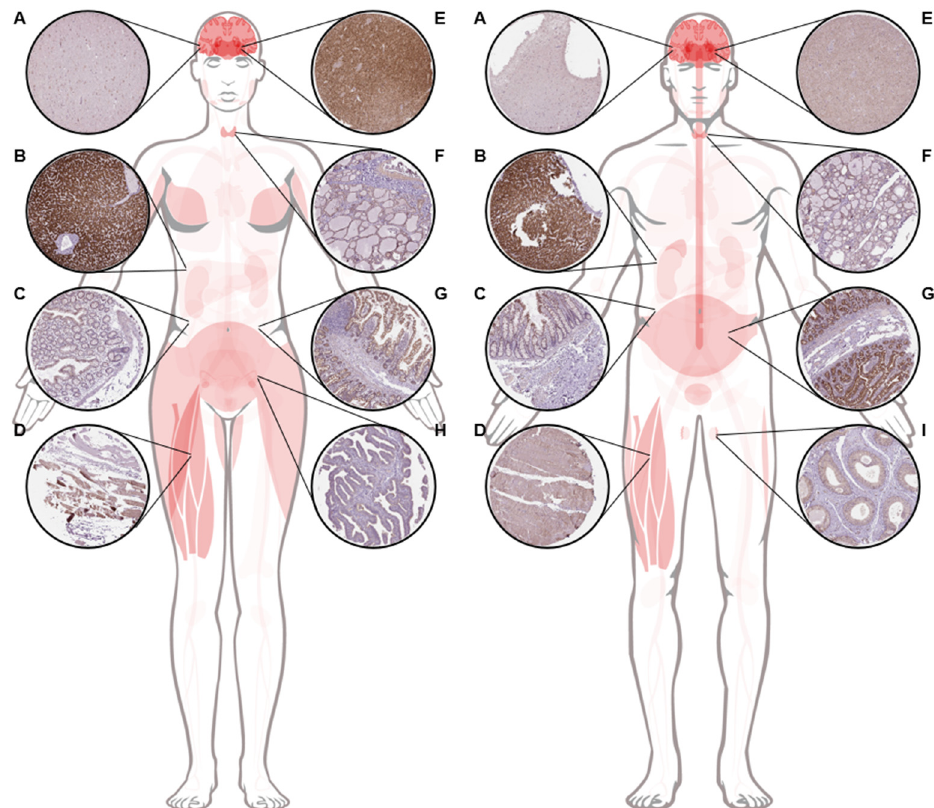
Figure 3. Anatomogram of LRP1B expression in normal human tissue. LRP1B expression data was derived from the antibody-based profiling of 76 different cell types corresponding to 44 normal human tissue types. Figure was prepared using anatomograms and immunohistochemistry images from version 20.1 of Human Protein Atlas available from https://www.proteinatlas.org/ENSG00000168702-LRP1B/tissue org (accessed on 14 June 2021) [23,24]. A , cerebral cortex. B , liver. C , colon, D , skeletal muscle. E , caudate. F , thyroid gland. G , small intestine. H , fallopian tube. I , testis.